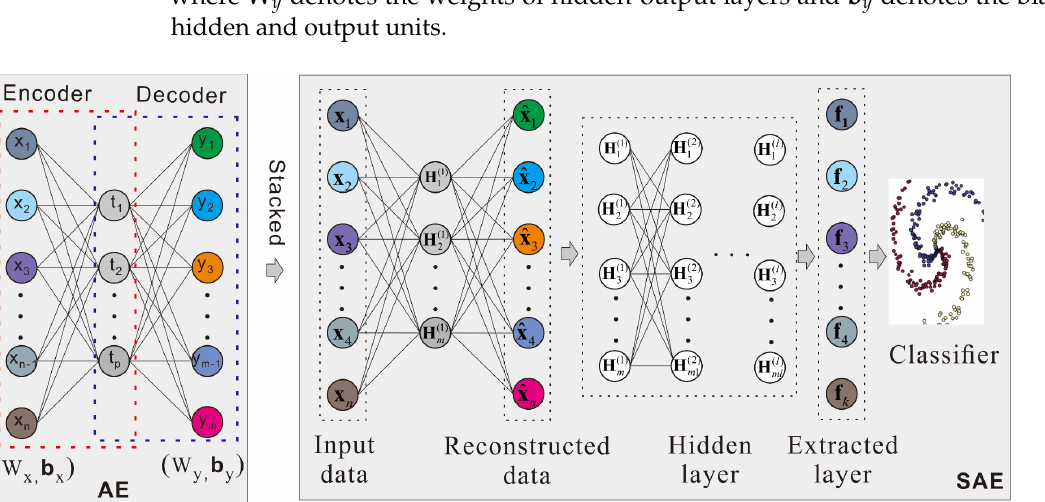
Figure 1. Illustration of AE and SAE: W x , b x , W y , b y represent the weights matrix and bias vector; x , t , y represent the input layer, hidden layer, reconstructed layer,